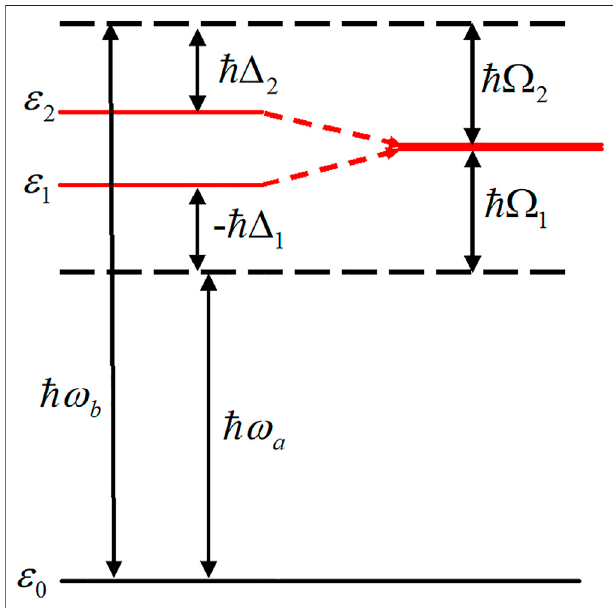
FIGURE 10 | Dynamic Stark-induced degenerate state with the Rabi frequencies ( Ω 1 and Ω 2 ) using two stationary linearly-polarized lasers with the frequencies, ω a and ω b , and detuning frequencies Δ 1 and Δ 2